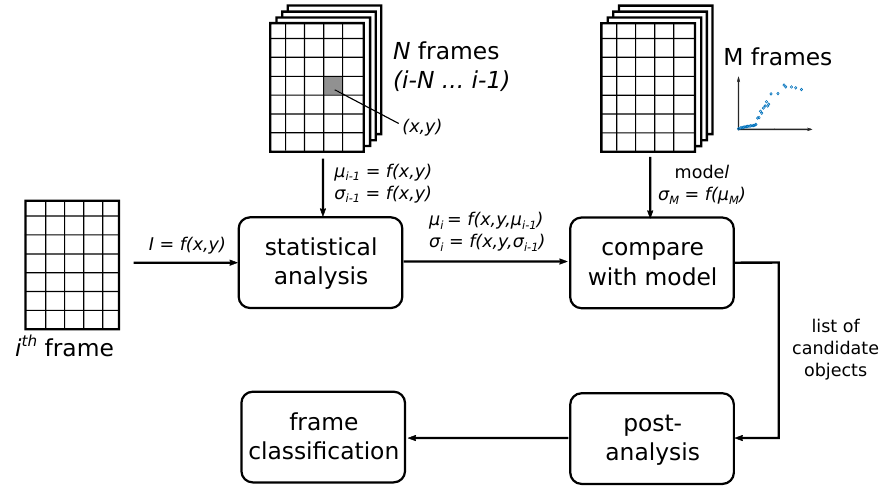
Figure 8. Block diagram of the proposed